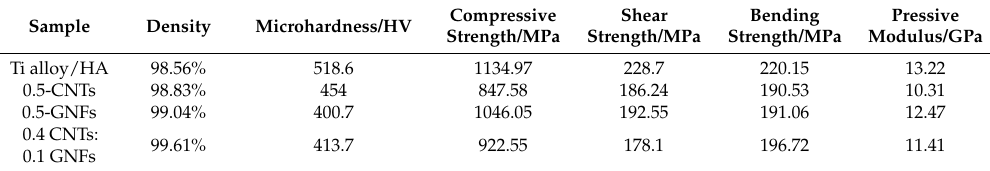
Figure 8. ( a , b ) TEM image of the 0.5-GNFs and 0.4 GNFs/0.1-CNTs nanocomposite in different areas, respectively. ( c – i ) the corresponding EDS spectrums of spots 1–7. Table 4. Mechanical properties of the nanocomposites sintered at 1000 ◦